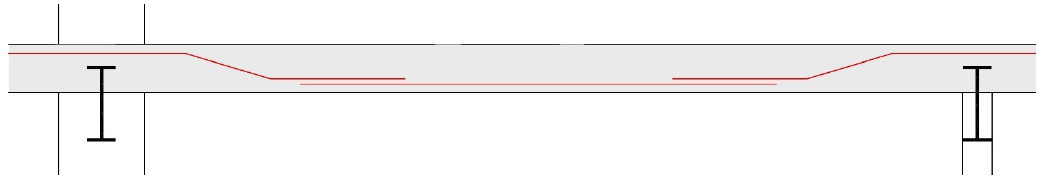
Figure 5. Reinforcements are inclined so as to maximize their performance against shear.